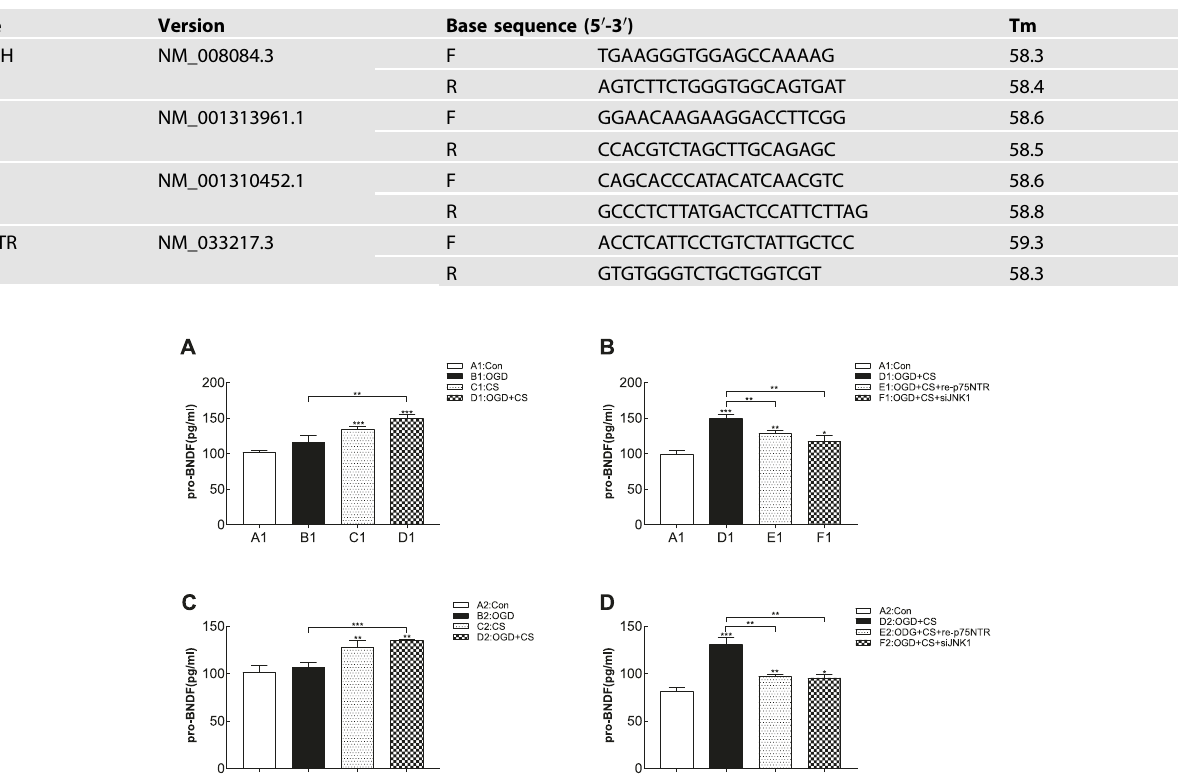
Fig. 1 Enzyme-linked immunosorbent assay (ELISA) of proBDNF in prefrontal cortical and hippocampal neurons ( n = 3 per subgroup). A , B Level of proBDNF in prefrontal cortical neurons with different treatments. C, D Level of in hippocampal neurons with different treatments. proBDNF content is expressed in pg/mL. Error bar represents mean ± SEM. * P < 0.05, ** P < 0.01, *** P < 0.001, **** P < 0.0001 versus control group. Con control, OGD oxygen-glucose deprivation, CS